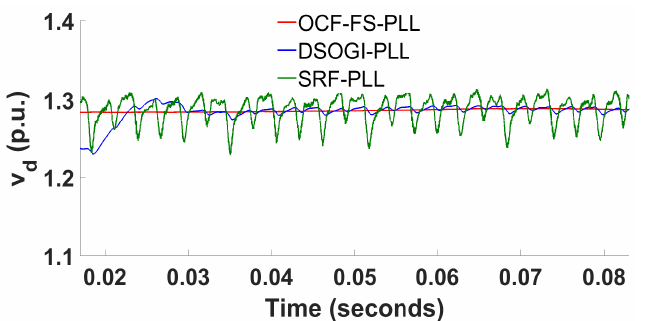
Figure 16. The v g , d positive sequence component during voltage sag under the presence of 5th, 7th, 11th, 13th, 17th, and 19th harmonics components.